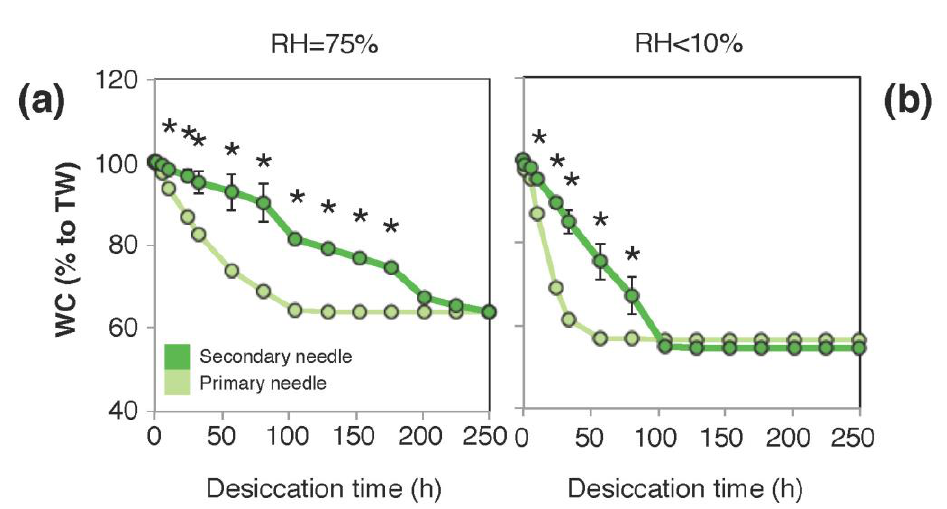
Figure 8. Loss of water in P. canariensis needles monitored during controlled desiccation and estimated through changes in water content (WC). The WC is expressed as fresh weight to turgor weight ratio in %. ( a ) Dehydration conducted at 75% RH. ( b ) Dehydration conducted at <10% RH. Secondary needles are depicted in dark green, primary needles in light green color. Data are mean ± SE ( n = 6). Asterisks depict significant differences between changes in water content at certain desiccation time ( p < 0.05).